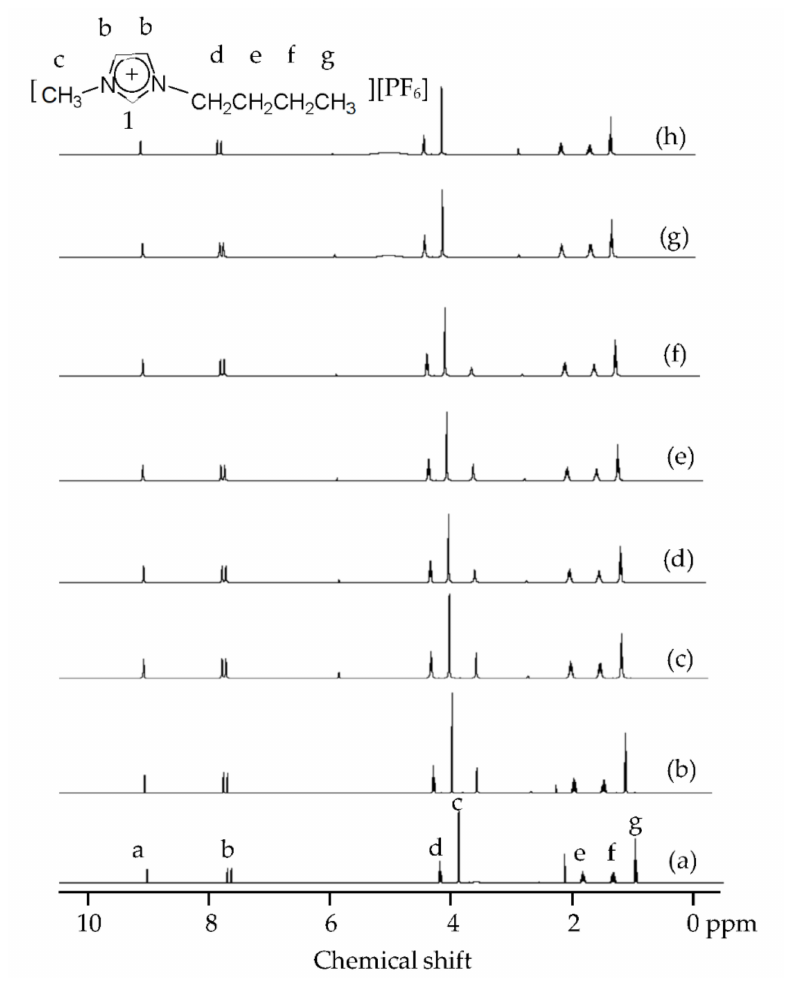
Figure 6. 1 H NMR spectra of the ( a ) IL, ( b ) IL-I, ( c ) IL-I containing CuI 2 − and extracted-copper IL-I at ( d ) 303 ( e ) 343 ( f ) 413 ( g ) 473, and ( h ) 543 K. The EXAFS spectra of copper in the IL-I and on the Cu/ITO during extraction were also recorded and analyzed in the k range of 3.5–11.5 Å − 1 . An over 95% reliability of the Fourier transformed EXAFS data fitting for copper was obtained. In all the EXAFS data analyses, the Debye–Waller factors ( ∆ σ 2 ) were less than 0.01 Å 2 (Tables 1 and 2). Table 1 shows that the bond distance of Cu-I was 2.55 Å with CNs (coordinated numbers) of 1.7–1.9 for CuI 2 − in the IL-I at 303–543 K. However, Table 2 shows that the bond distance of Cu-I for CuI on the Cu/ITO was 2.56–2.57 Å with CNs of 3.1–3.4 at 303–543 K. Table 1. Structural parameters of extracted copper in the IL-I at 303–543